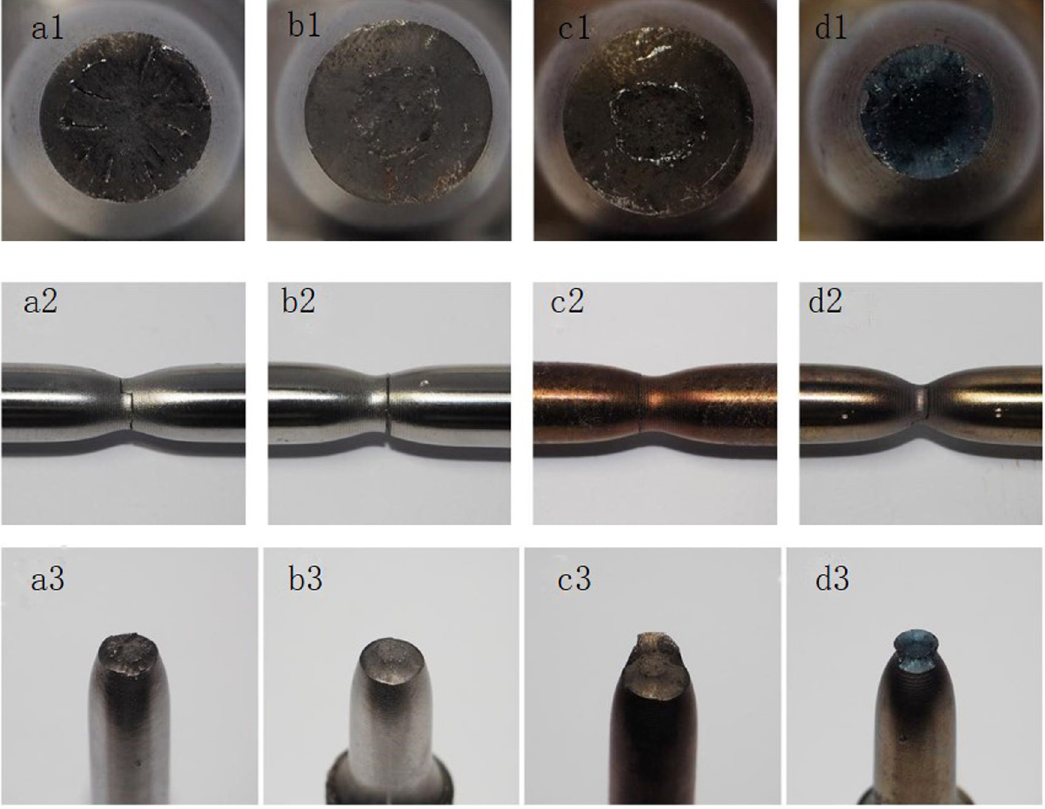
Figure 6: Macroscopic morphology of fracture of 42CrMo after high - temperature tensile test: ( a ) 25°C, ( b ) 150°C, ( c ) 250°C, and ( d )